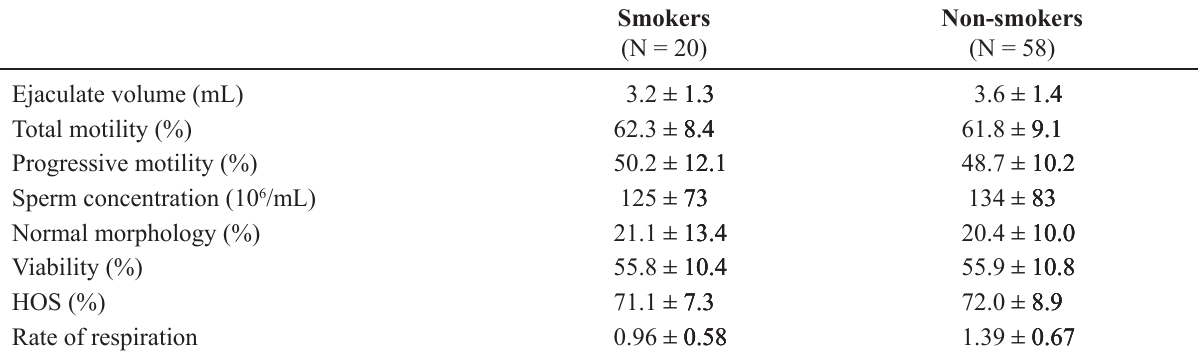
The values are mean �� SD. The p value between smokers and non-smokers for the rate of respiration (in �M O